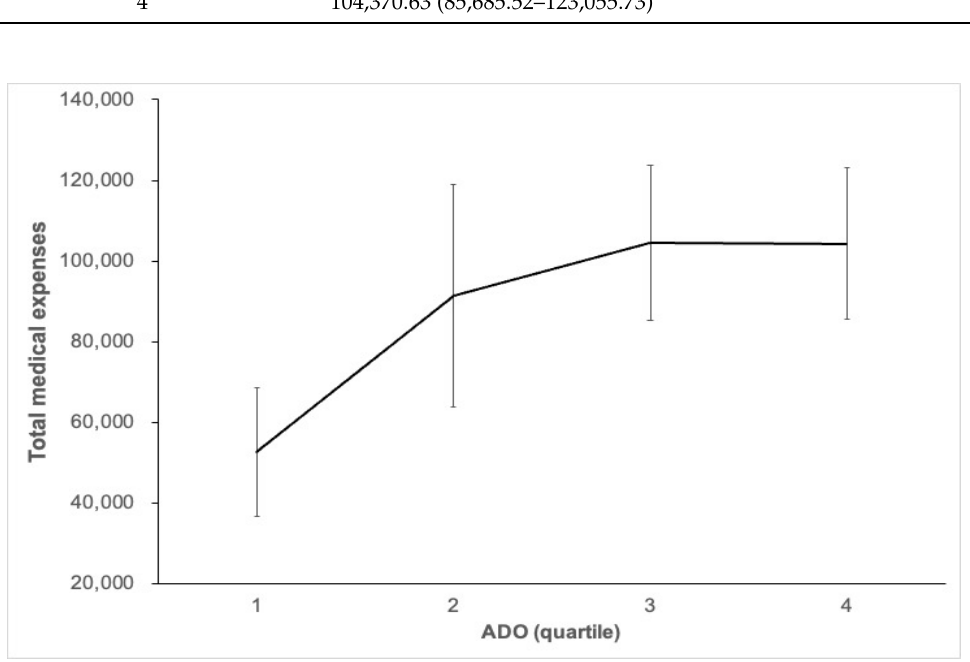
Figure 3. This shows a linear trend between the ADO quartiles and total medical expenses ( p =